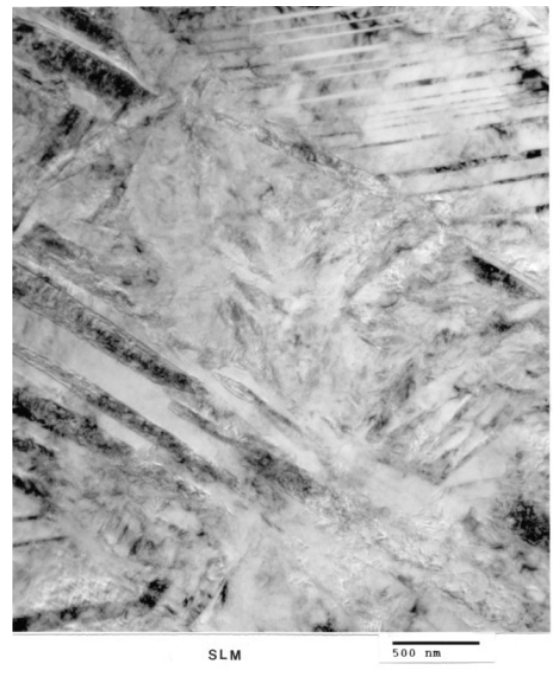
Figure 12. TEM view of SLM α - α ′ martensite and twinned